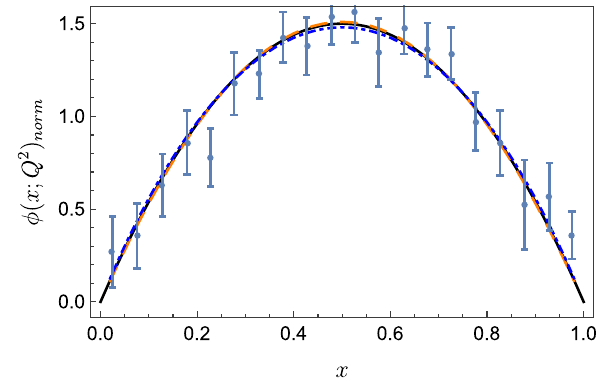
Fig. 5 Comparison between the normalized DA, see Eq. (61) and the data from Ref. [75]. The final scale is Q = 3 . 16 GeV. The full line showsthepQCDprediction.ThedashedlinecorrespondstotheGSWL2 parametrization and the dot-dashed line is related to the GSWL1